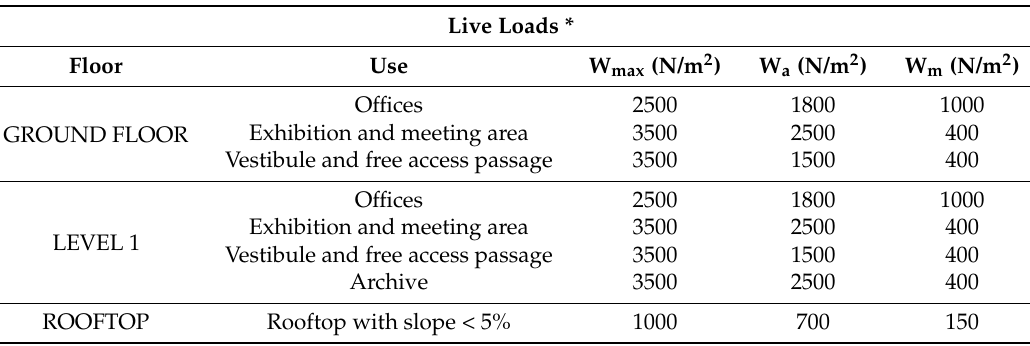
Table 3. Live loads by